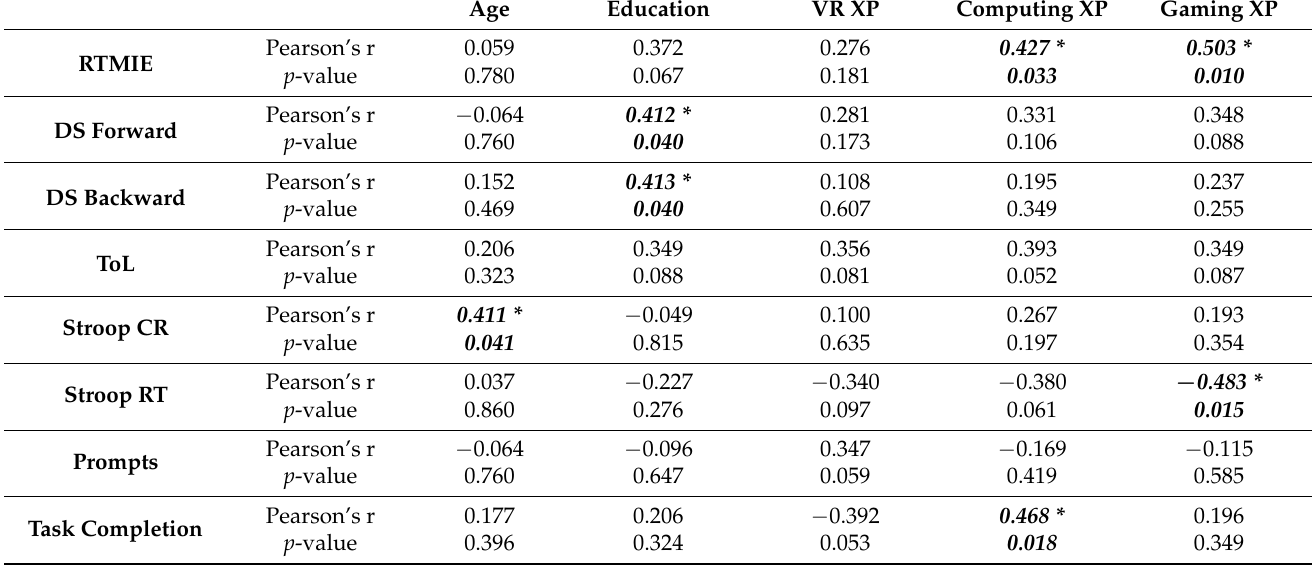
Table 3. Pearson’s correlations between demographics and performance metrics.